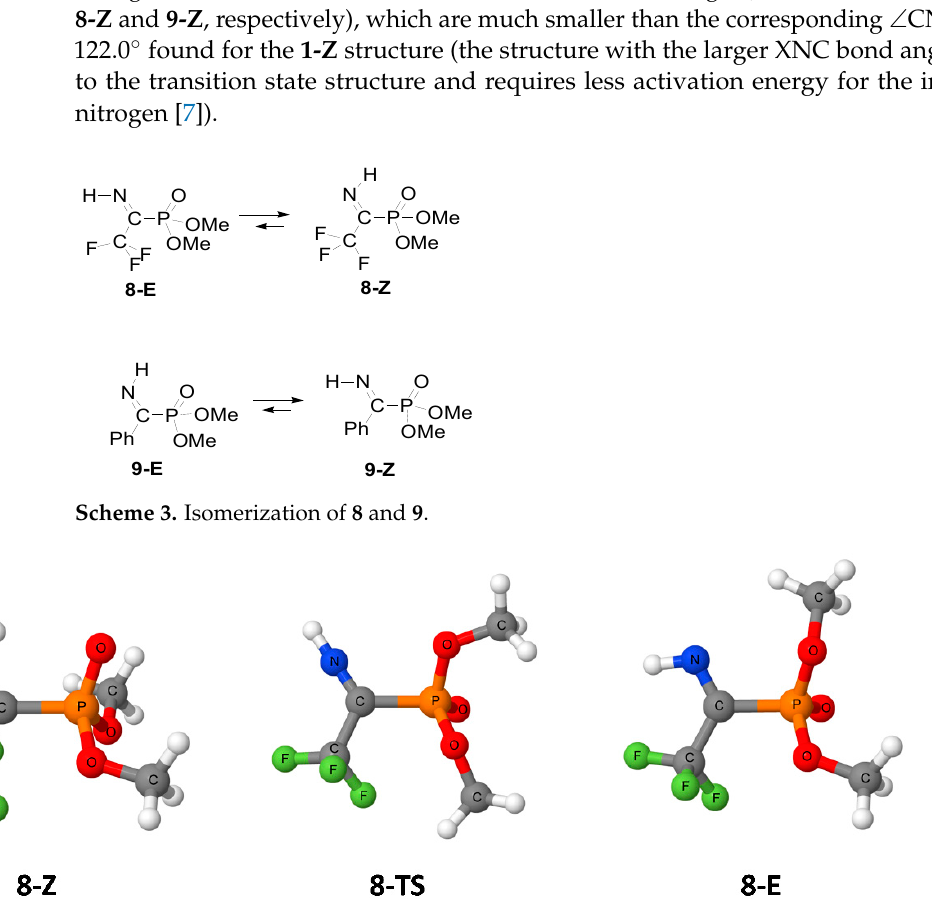
Figure 11. Optimized structures of the Z- and E-isomers of compound 8 ( 8-Z and 8-E , respectively), and the structure corresponding to the transition state of the isomerization reaction ( 8-TS ).